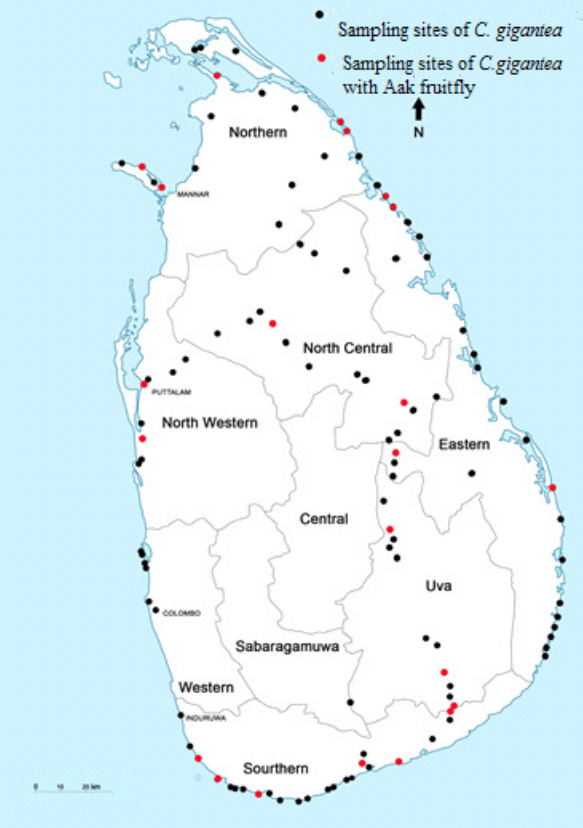
Figure 1: Sampling sites of Calotropis gigantea and Aak fruitfly ( D. persicus ) in Sri